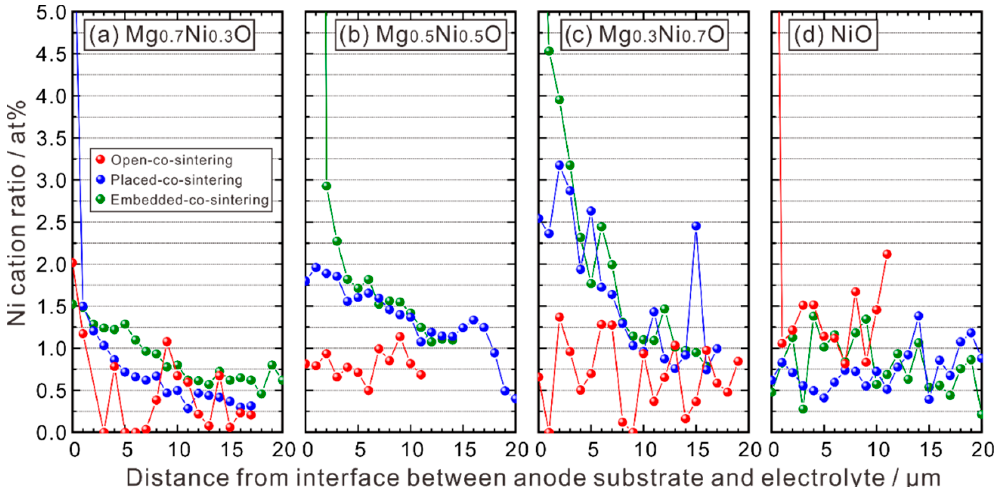
Figure 4. Ni cation ratio in the electrolyte layer of the half cells with the anode substrates of ( a ) BZY20-50 wt % Mg 0.7 Ni 0.3 O, ( b ) BZY20-50 wt % Mg 0.5 Ni 0.5 O, ( c ) BZY20-50 wt % Mg 0.3 Ni 0.7 O, and ( d ) BZY20-50 wt % NiO. All the half cells were co-sintered at 1600 ° C in oxygen for 10 h with the method shown in Figure 1. The Ni cation ratio was measured with EPMA-WDS line analysis following the position shown in Figure 2 (red line) from the interface between the anode substrate and the electrolyte.